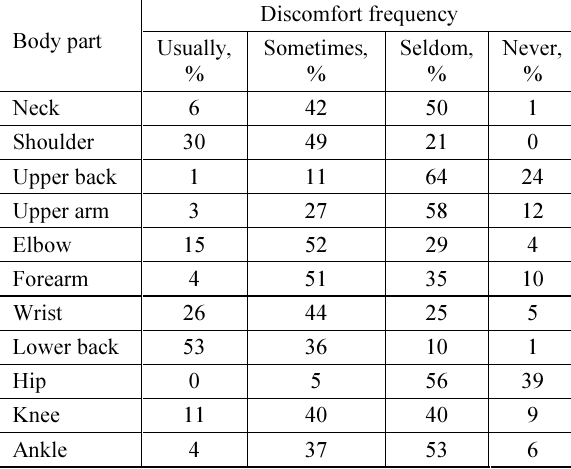
Table 4. Survey of the workers’ continuity of pain occurrence Body